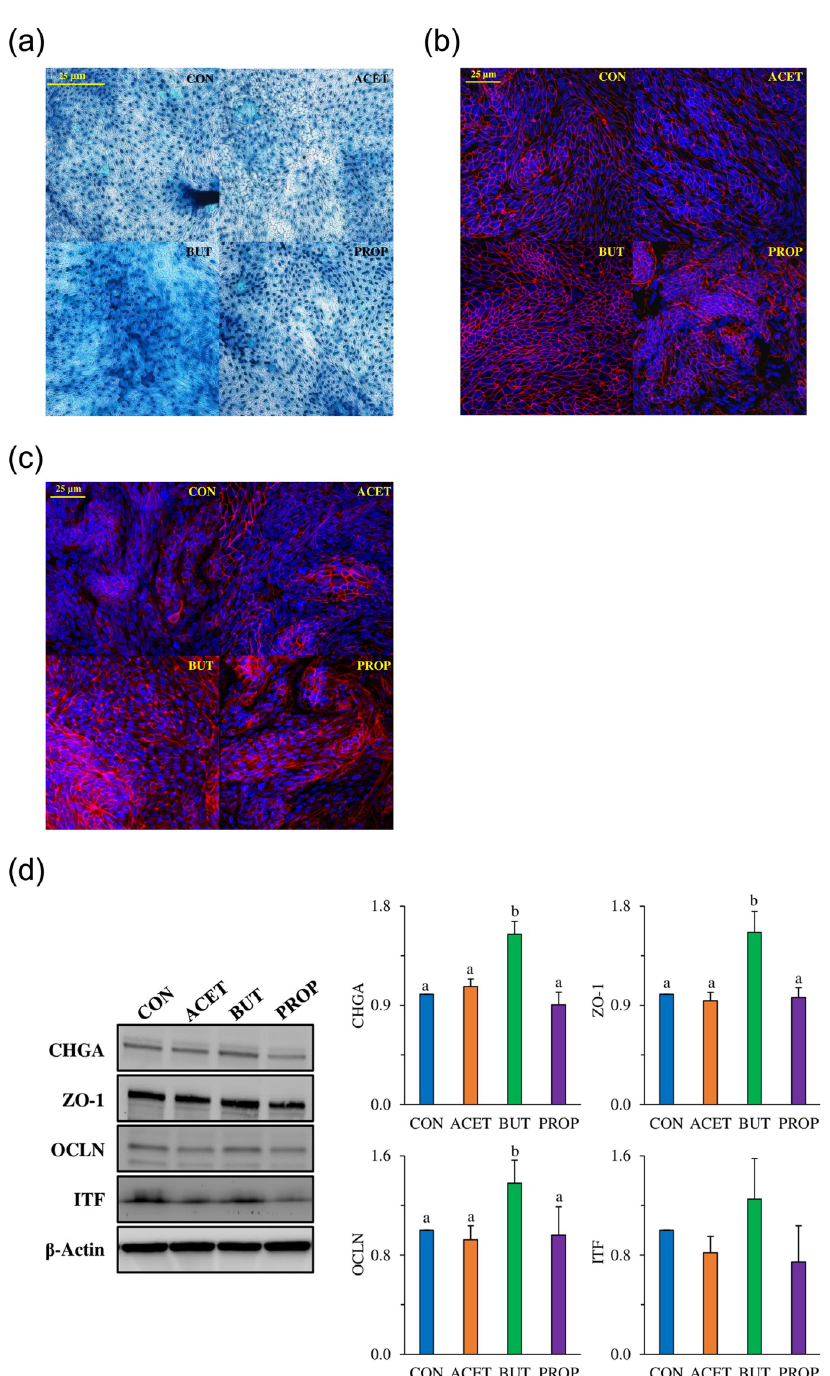
Fig 7. (A) Alcian blue/Hematoxylin staining 2D enteroids treated with 10 mM acetate (ACET), butyrate (BUT), and propionate (PROP) compared to controls (CON). (B) Zonula occludens-1 (ZO-1) staining (red) and (C) Claudin-3 (CLDN3) staining (red). Nuclei are stained with DAPI (blue). (D) Western blot data for Chromogranin-A (CHGA), Zonula-occludens-1 (ZO-1), occludin (OCLN), and Trefoil Factor 3 (TFF3). Samples were compared to β -actin as a housekeeping protein. Confocal images are representative of several fields of view at 40X magnification. Treatments are compared to controls (CON) which are set to 1.0 and superscripts (a,b,c,d) indicate statistical significance between treatments at P < 0.05, n =